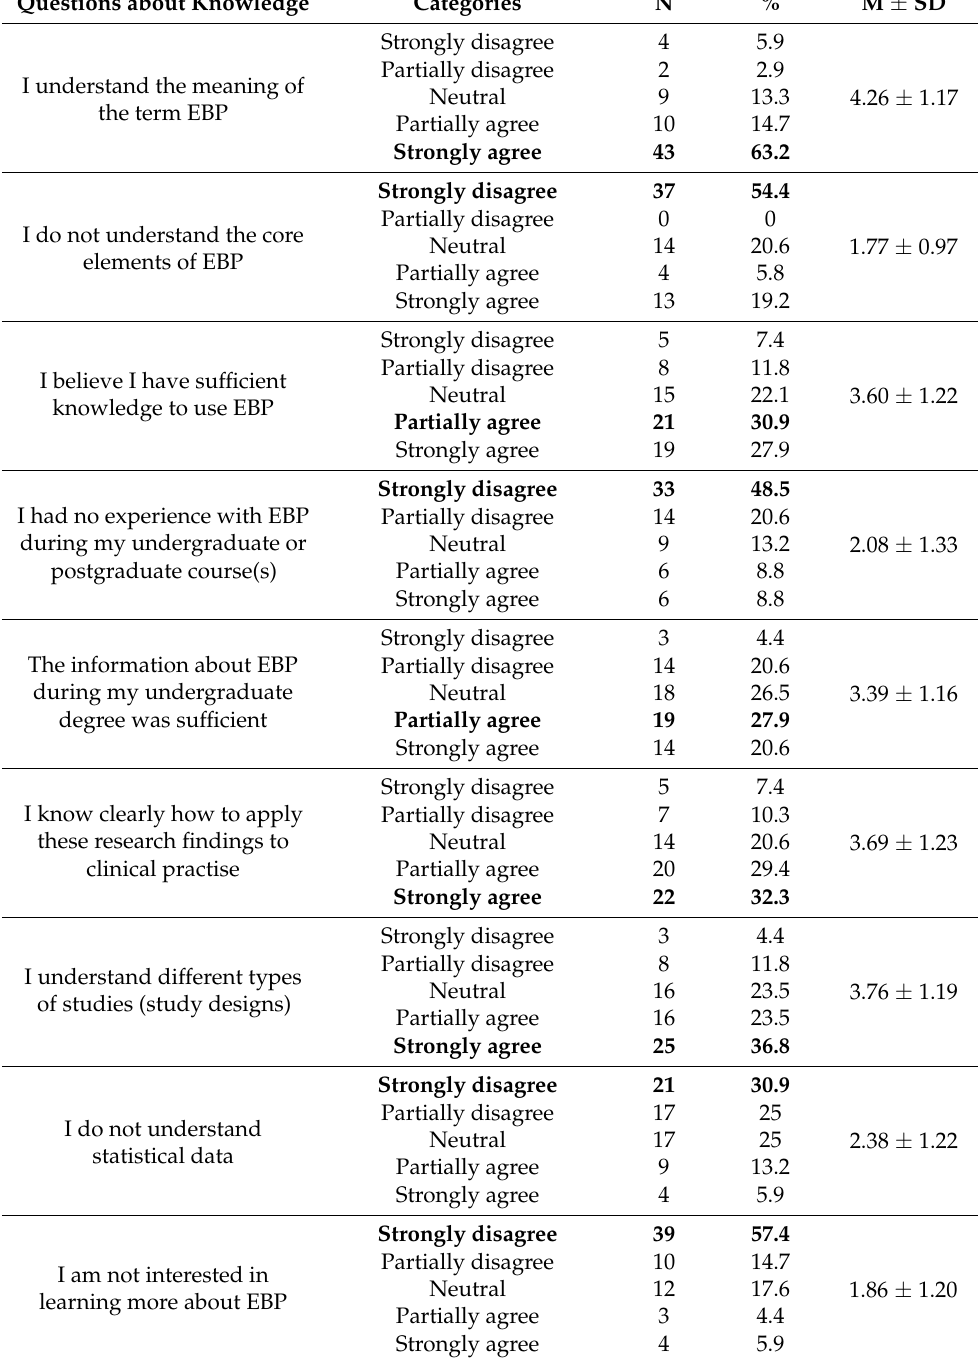
Table 2. Self-reported characteristics related to